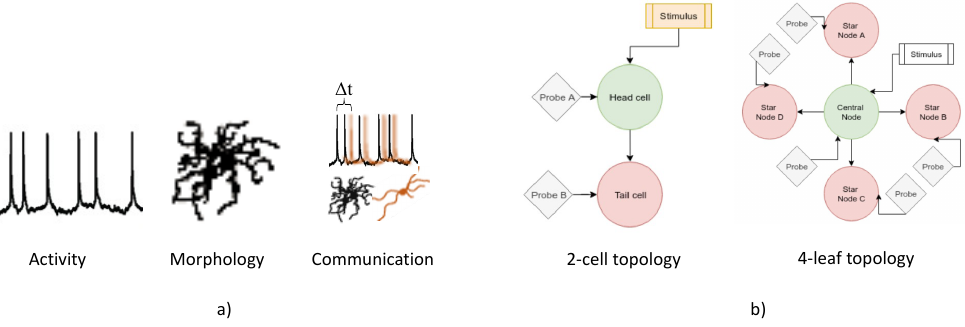
Figure 3. The visual representation of the ( a ) data types used in our paper (activity, morphology and communication) and ( b ) the topological configurations (2-cell topology and 4-leaf